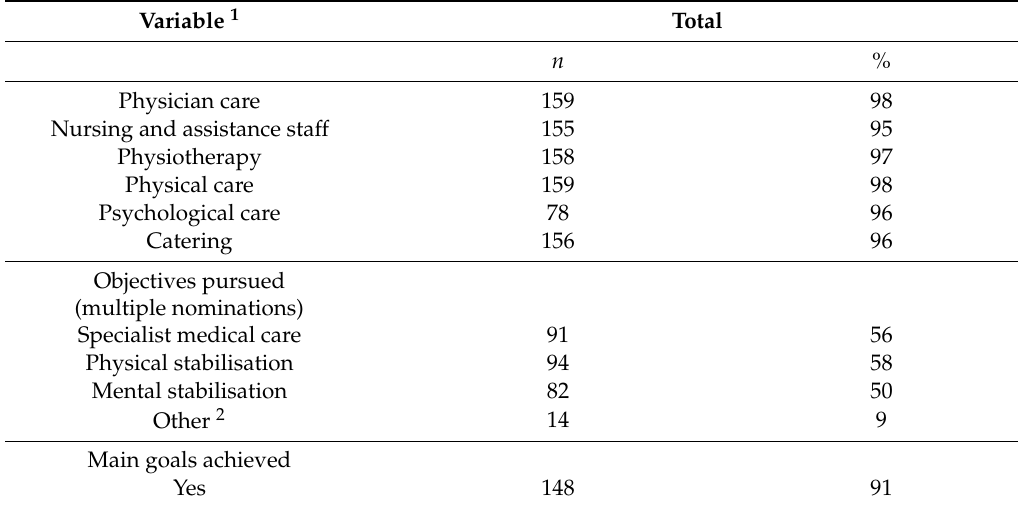
Table A2. Therapy satisfaction and individuals’ goals for